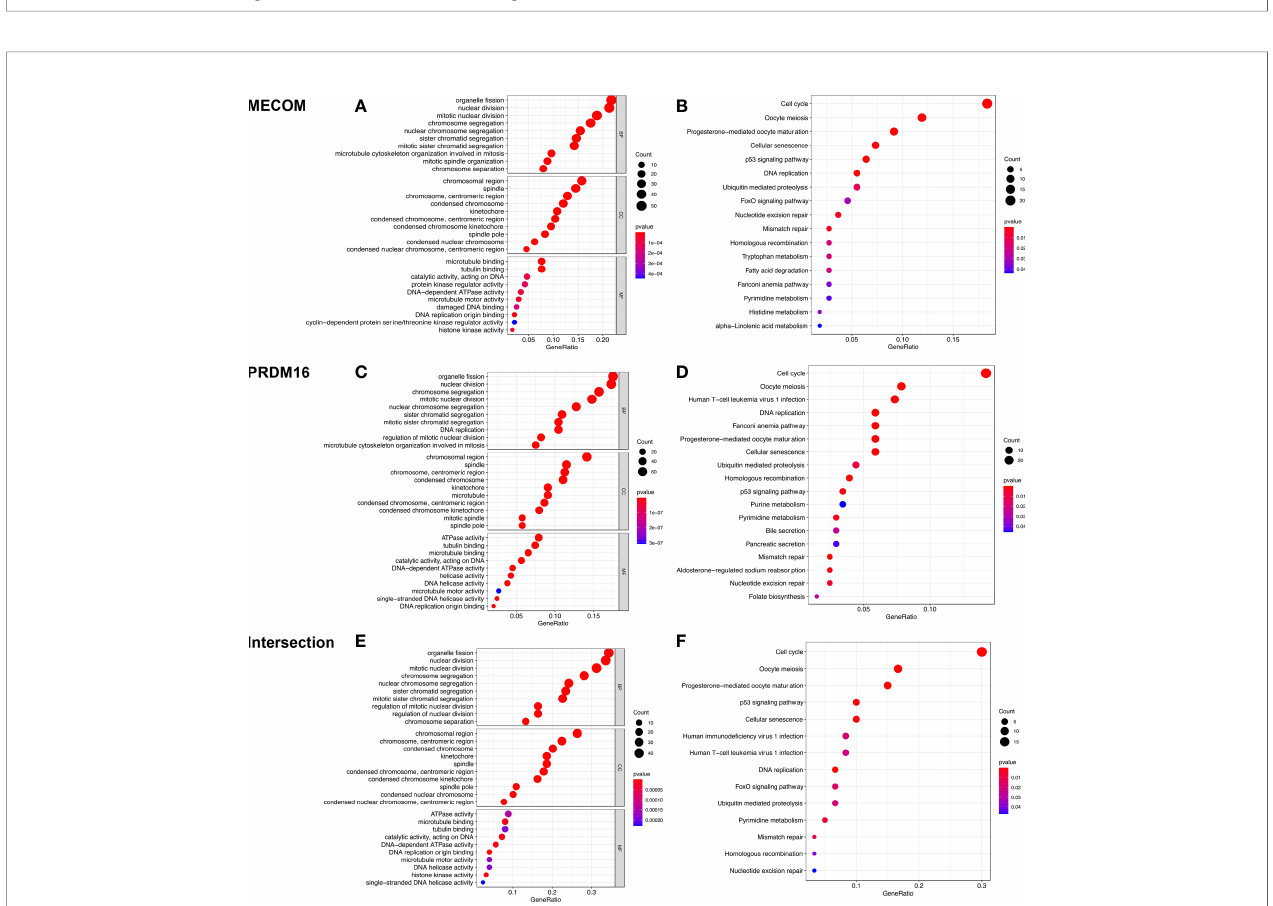
FIGURE 9 | GO and KEGG analyses of MECOM (A, B) and PRDM16 (C, D) coexpression genes and intersection of coexpression genes (E, F) . MECOM, MDS1 and EVI1 complex locus, also called PRDM3; PRDM16, PR domain containing 16, also called MEL1; LUAD, lung